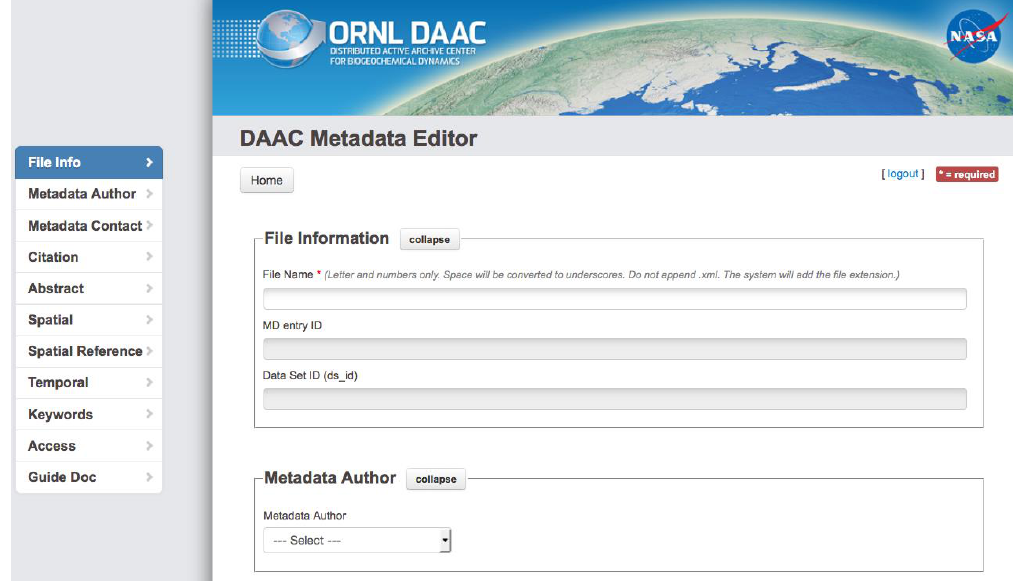
Figure 7. Metadata and documentation editor.